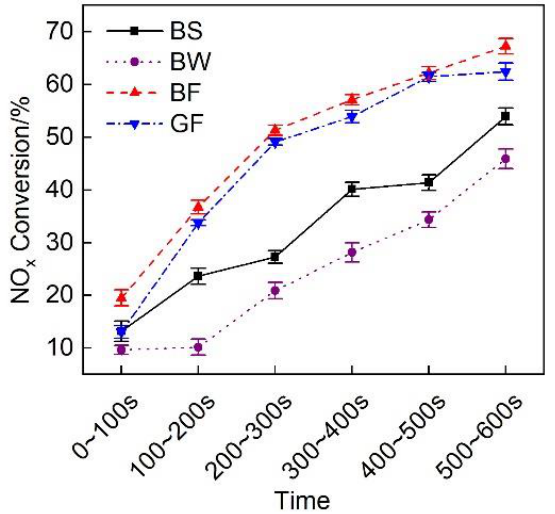
Figure 13. NO x conversion efficiency at each substage of the initial idling stage of the different exhaust pipe covering schemes.